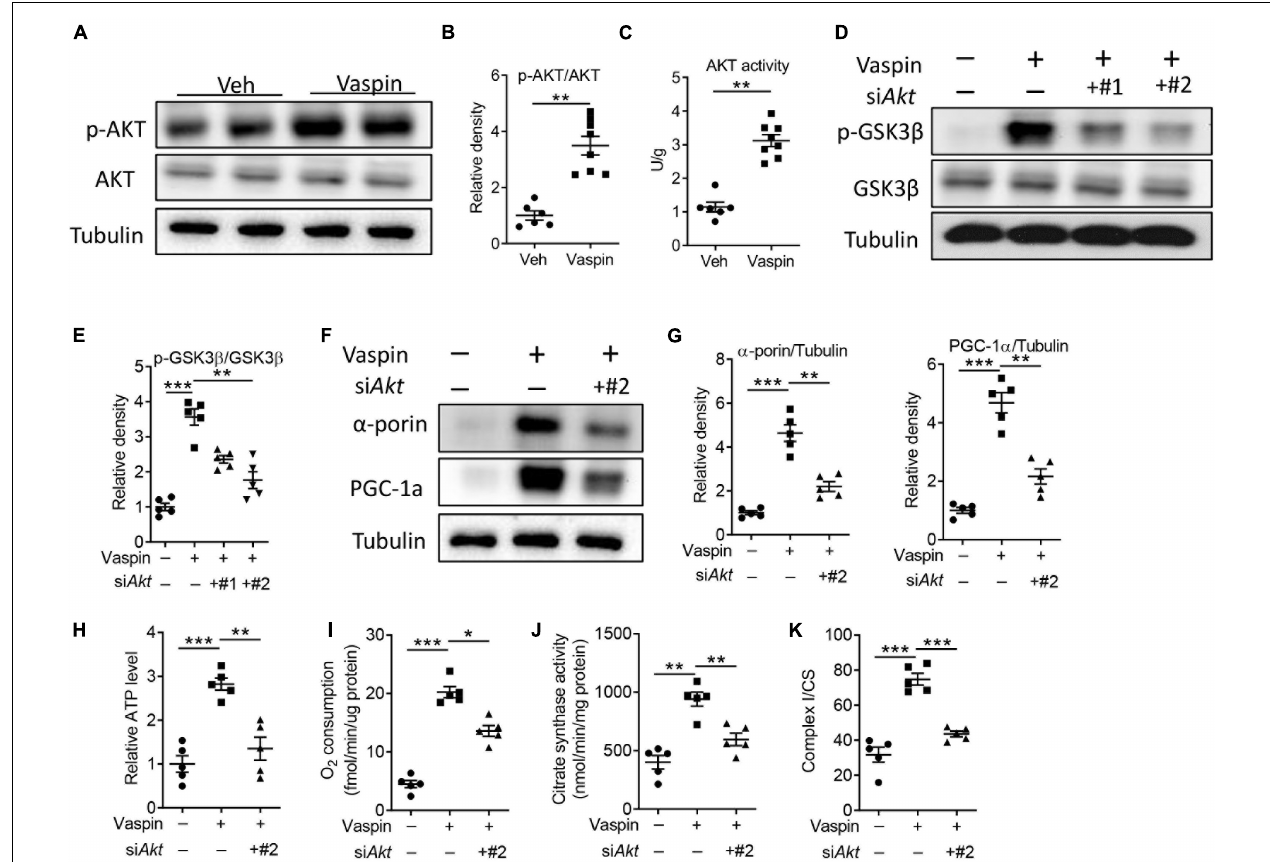
FIGURE 5 | Vaspin improves cardiomyocyte mitochondrial function by upregulating phosphorylated AKT. (A,B) Sixteen-week-old A-ZIP/F-1 mice were treated with recombinant vaspin protein (100 µ g/mouse) by osmatic pump for 8 weeks. Western blot analysis of cardiac phosphorylated AKT and AKT (A) , and quantitative analysis of relative density (B) . (C) The measurement of cardiac AKT activity by commercial kit. (D–K) Primary cardiomyocytes (1 10 6 ) were incubated with 1 10 5 viral particles encoding si Akt for 48 h (#1 and #2), then treated with recombinant vaspin protein (2.5 µ g/ml) for 24 h. Western blot analysis of phosphorylated GSK3 β and GSK3 β (D) , and quantitative analysis of relative density (E) . Western blot analysis of α -porin and PGC-1 α (F) , and quantitative analysis of relative density (G) . (H–K) Measurement of relative ATP production (H) , oxygen consumption (I) , citrate synthase activity (J) , and ratio of complex I/CS (K) in extracted cardiomyocyte mitochondria. Results are shown as mean ± SEM, and n = 6–8 mice/group or five independent experiments. * p < 0.05, ** p < 0.01, *** p <